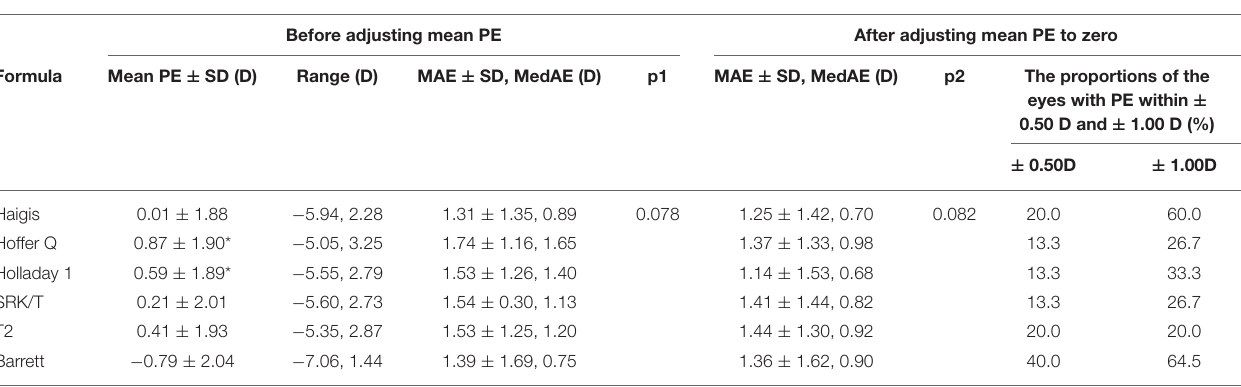
TABLE 6 | Postoperative refractive results of group C (AL >